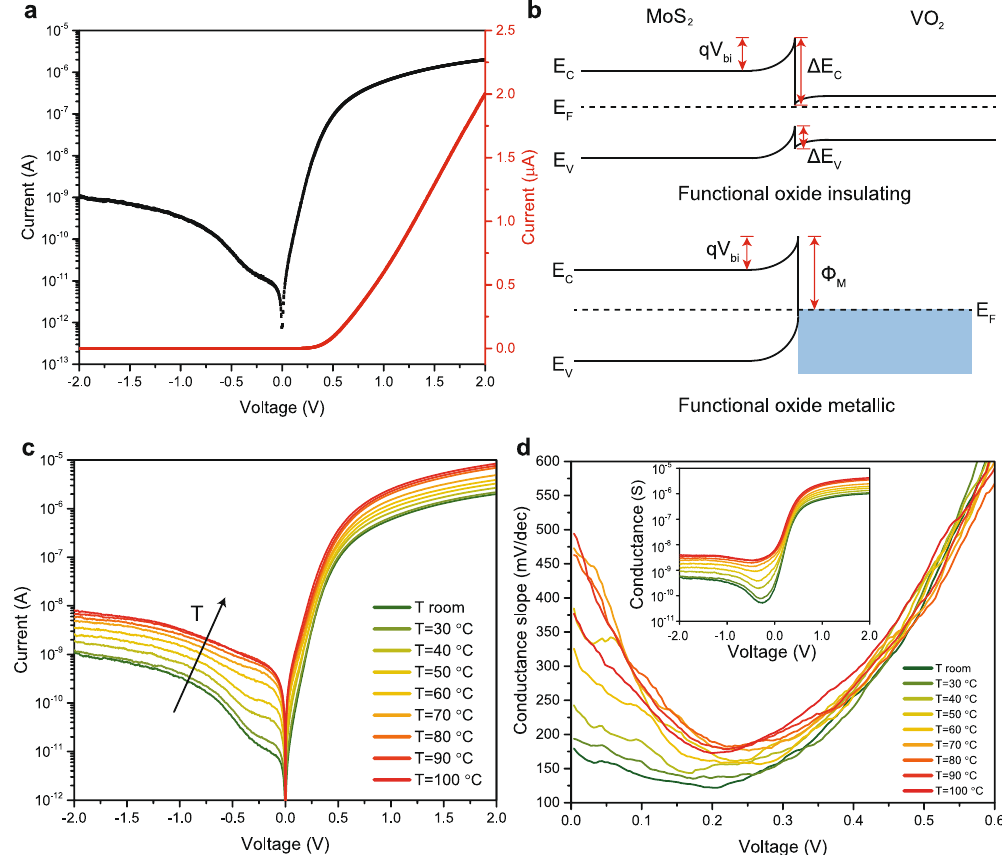
Figure 2. Electrical characteristic of the MoS 2 /VO 2 heterojunction. ( a ) Electrical I–V double-sweep characteristic of device D1 at room temperature in semi-logarithmic (black) and linear (red) scales. The device presents a rectification behavior with no significant hysteresis. ( b ) Qualitative band diagram of the MoS 2 /VO 2 heterojunction for the insulating and metallic phase of the functional oxide. The VdW gap at the junction is not represented and the polycrystalline nature of VO 2 is not considered. ( c ) Evolution of the electrical characteristic of D1 with increasing temperature. Both forward and reverse current are boosted by the temperature increase, with a more pronounced enhancement in the window around the IMT temperature (60–80 °C). ( d ) Extracted conductance slope from the exponential regime of the forward current. The conductance slope increases across the VO 2 IMT. Inset: conductance of device